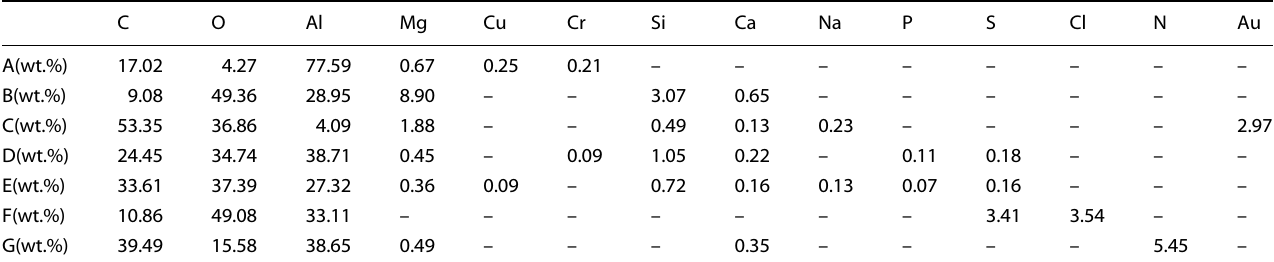
Table 2. EDS analysis results of surface fi lms located on various areas corresponding to SEM images in Fig.